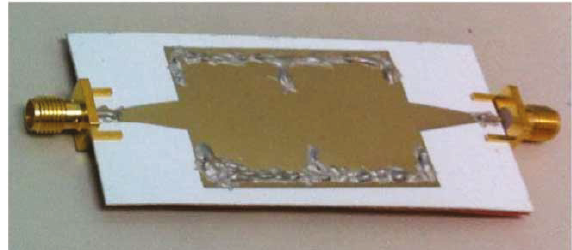
Figure 15: Cavity-backed SIW antenna on textile